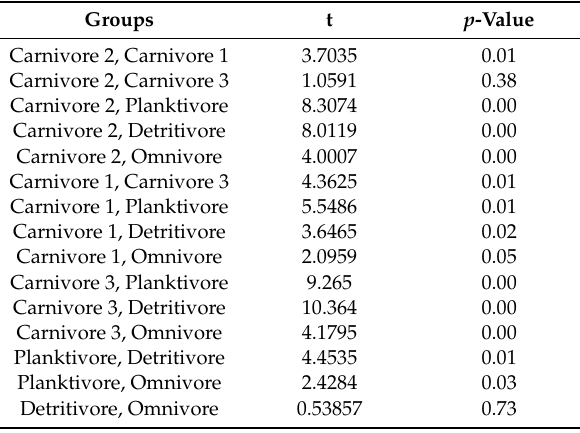
Table 1. Permutational MANOVA (PERMANOVA) results of the pairwise comparisons of the diet of the di ff erent feeding guilds analyzed for stomach contents analysis